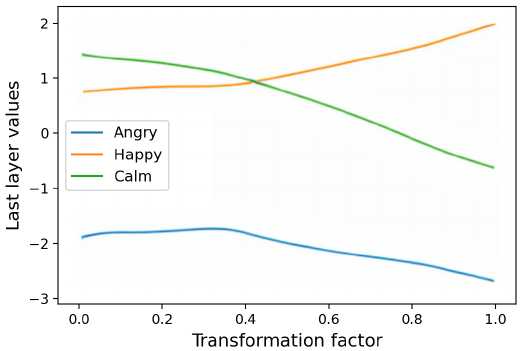
Figure 7. Representation of how the values of the network prediction change when applying changes by a factor in the spectrogram in Figure